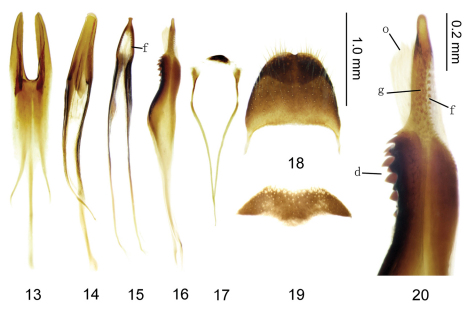
Male terminalia of Tillicera sensibilis sp. n., holotype 13–14 tegmen (13 dorsal view 14 lateral view) 15–16 phallus (15 ventral view 16 lateral view) 17 spicular fork 18 tergum VIII 19 sternum VIII 20 phallus, lateral view. Abbreviations: d = dorsal denticles f = file-like structures on phallic ventral membrane g = granular structures; o = median orifice.